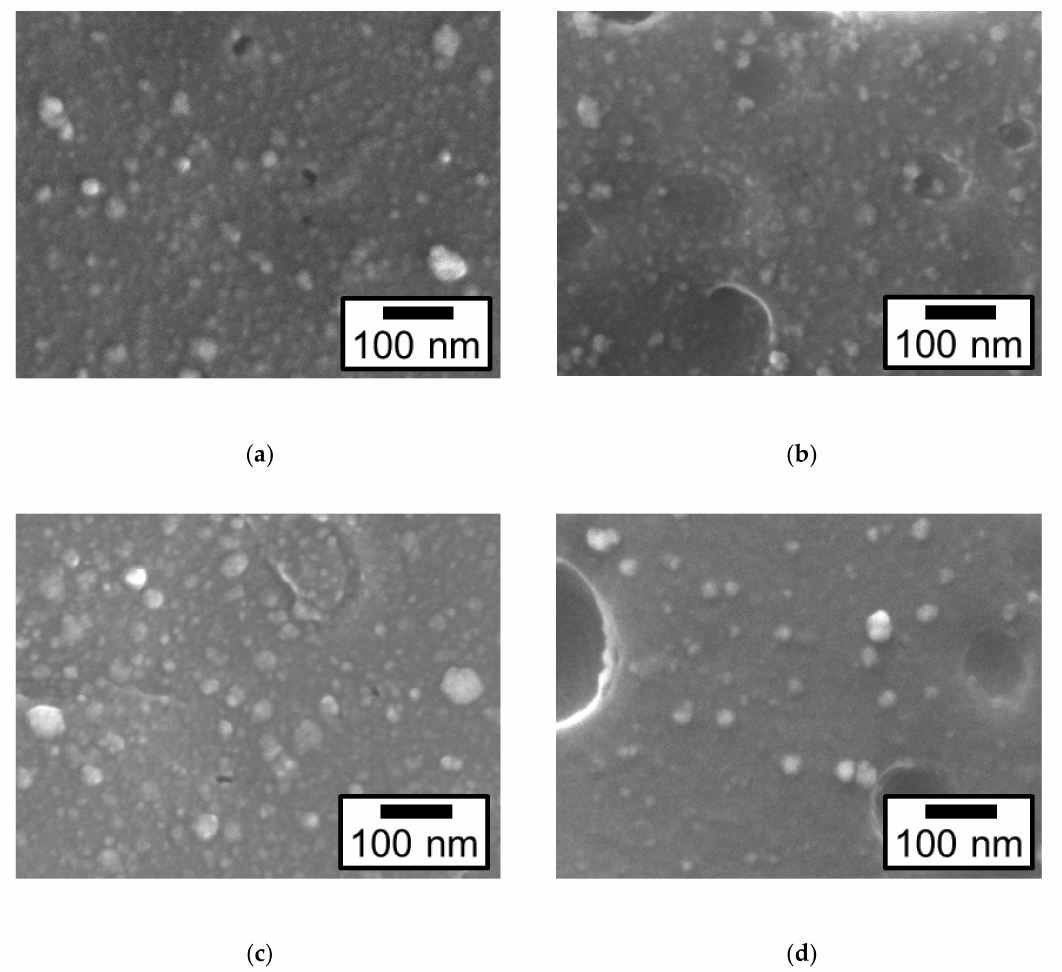
Figure 3. Field-emission (FE) SEM images of the surface morphology of four types of Pt/ABS samples: ( a ) Pt/ABS-untreated, ( b ) Pt/ABS-Etch, ( c ) Pt/ABS-Charge, and ( d )